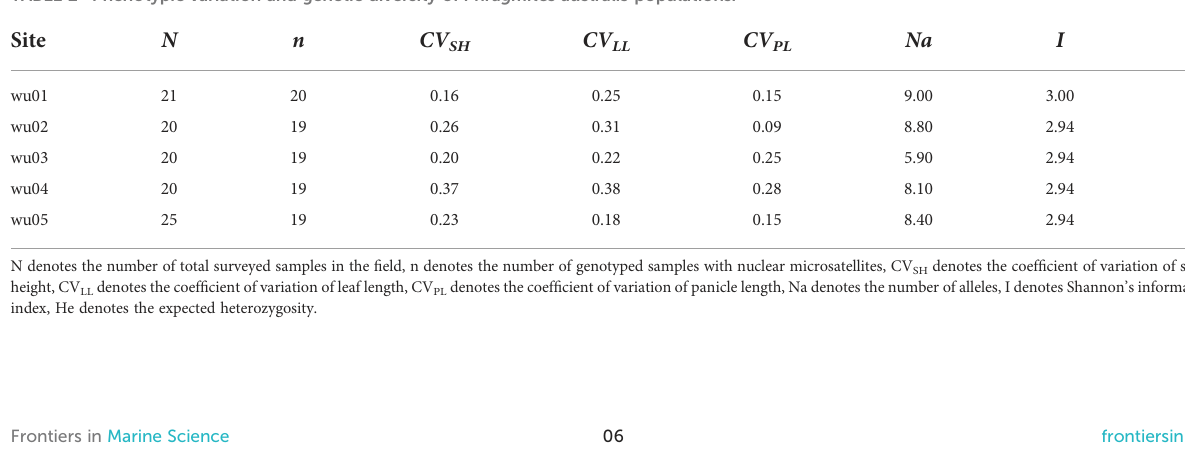
TABLE 2 Phenotypic variation and genetic diversity of Phragmites australis populations. Site N